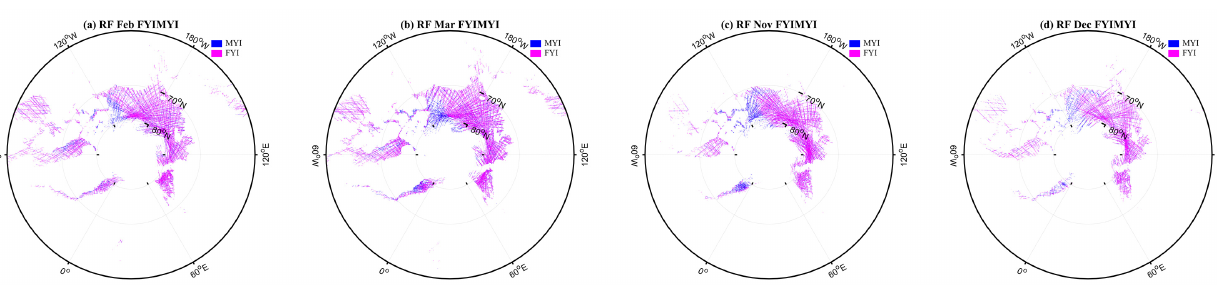
Figure A13. RF for FYI-MYI classification using the data in April as the training set. The data in ( a ) February, ( b ) March, ( c ) November, and ( d ) December are used as the test set in turn.